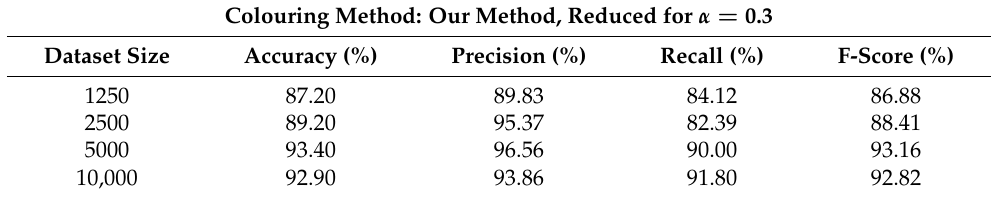
Table 9. Performance metrics for our method, processed with α = 0.3. Colouring Method: Our Method, Reduced for α = 0.3